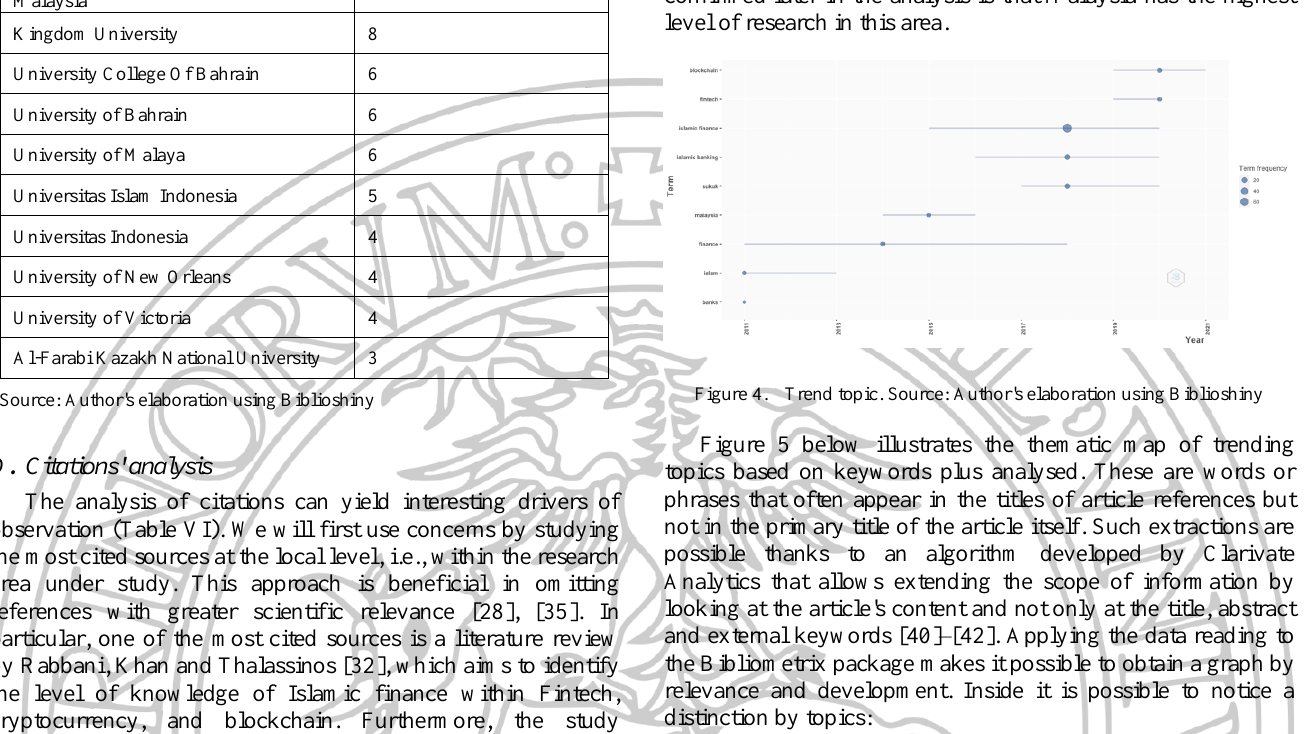
Figure 4. Trend topic. Source: Author's elaboration using